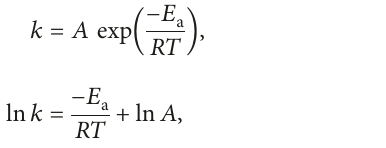
c -oryzanol standards (A) and hydrolysis products 235nm ) of